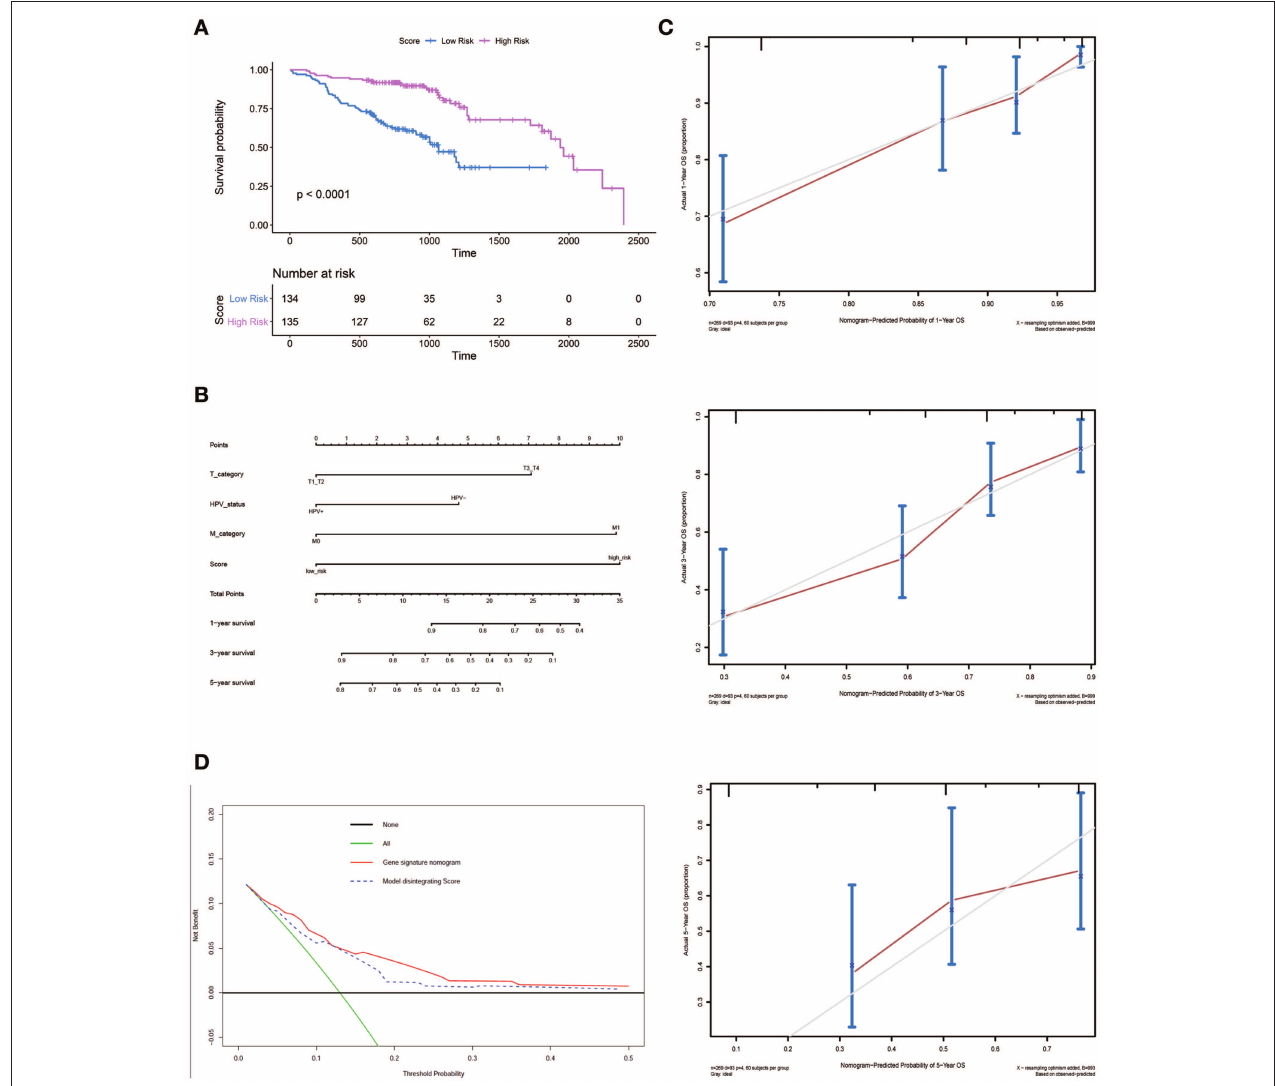
FIGURE 3 | Nomogram plot for patients with Head and Neck Squamous Cell Carcinoma. (A) Overall survival analysis on signature score in the GSE65858 dataset. (B) The gene nomogram was developed with signature score, T category, M category and HPV status. (C) Calibration curves of the gene nomogram. The y-axis represents the actual overall survival rate. The x-axis represents the predicted overall survival rate. The gray diagonal represents a perfect prediction of an ideal model. Dark red solid lines indicate the performance of the nomogram, where closer to the diagonal dashed line indicates a better prediction. (D) Decision curve analysis for the gene signature nomogram and the model without Score. The y-axis measures the net benefit. The red solid line represents the gene signature nomogram. The blue dashed line represents model without Score. The green line represents the assumption that all patients have died. Thin black line represents the assumption that no patients have